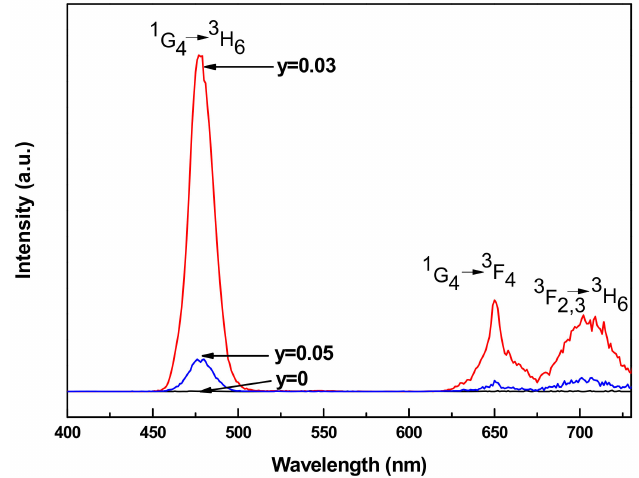
Figure 2. Upconversion luminescence spectra of Tm 3+ /Yb 3+ co-doped LNT glasses with different Yb 3+ contents pumped at 976 nm